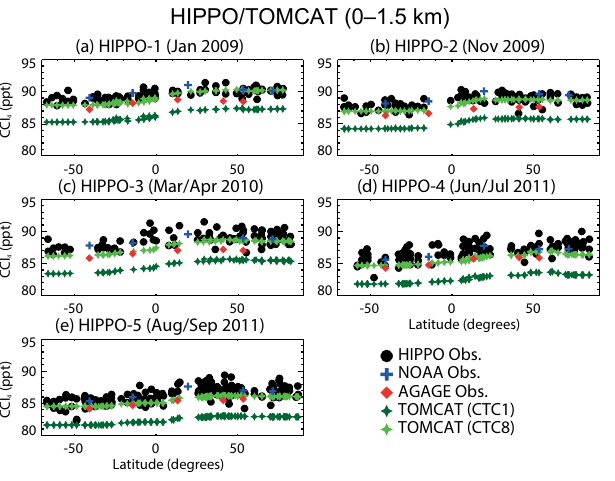
Figure 4. Latitude cross section of HIPPO observations of CCl 4 (ppt, black circles) between the surface and 1.5km altitude from flights during five campaigns between January 2009 and Septem- ber 2011. Also shown are mean surface observations from the AGAGE (red diamond) and NOAA (blue + ) networks (see Table 1 and Fig. 2) for the months of the campaign. Results from model tracers CTC1 and CTC8 are also shown.